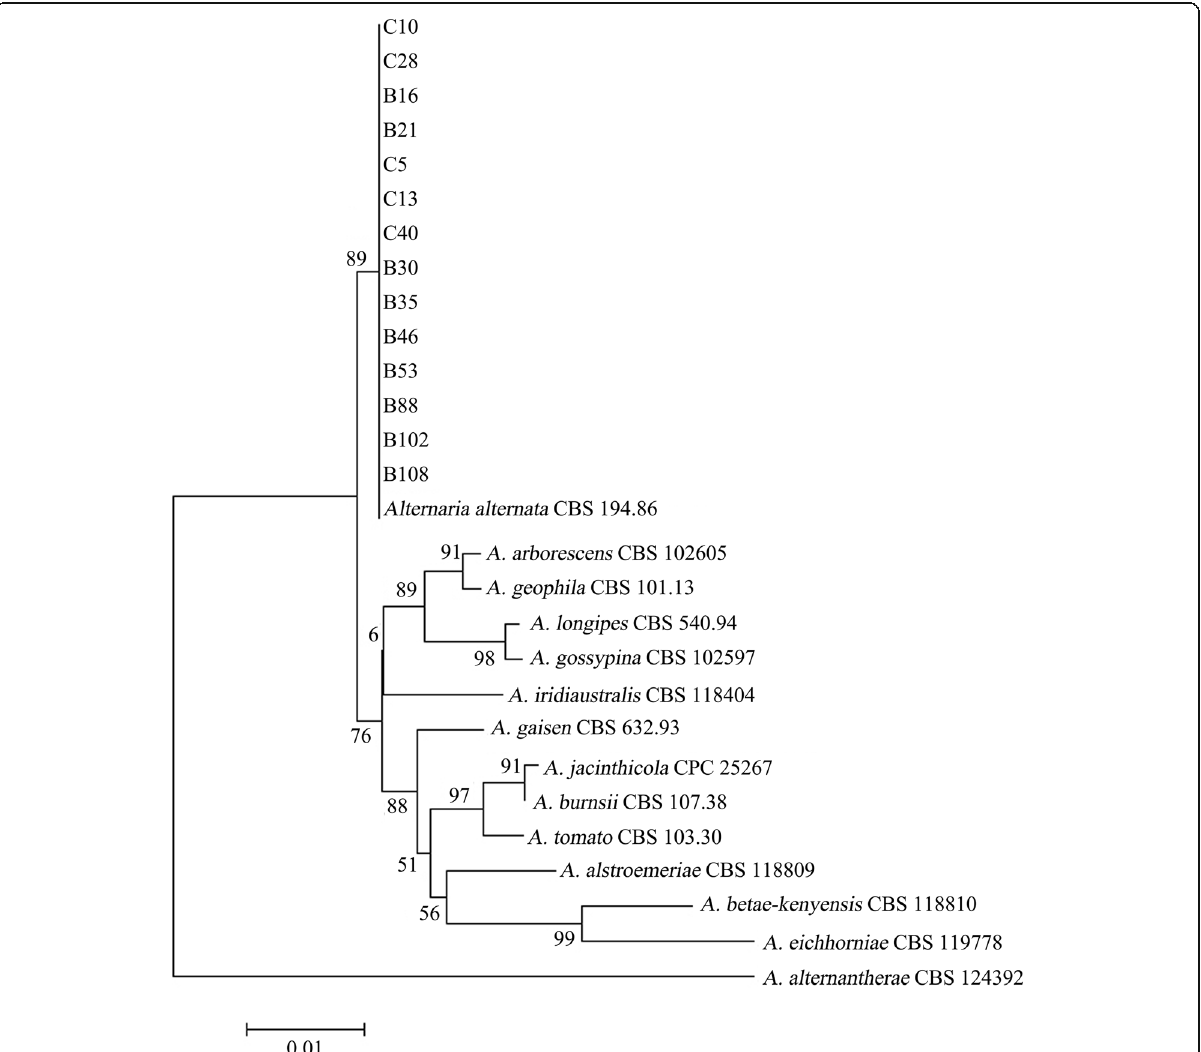
Fig. 1 Phylogram generated from maximum parsimony analysis based on sequences of ITS and KOG1058, showing the phylogenetic relationship of the tested isolates with A. alternata and other Alternaria